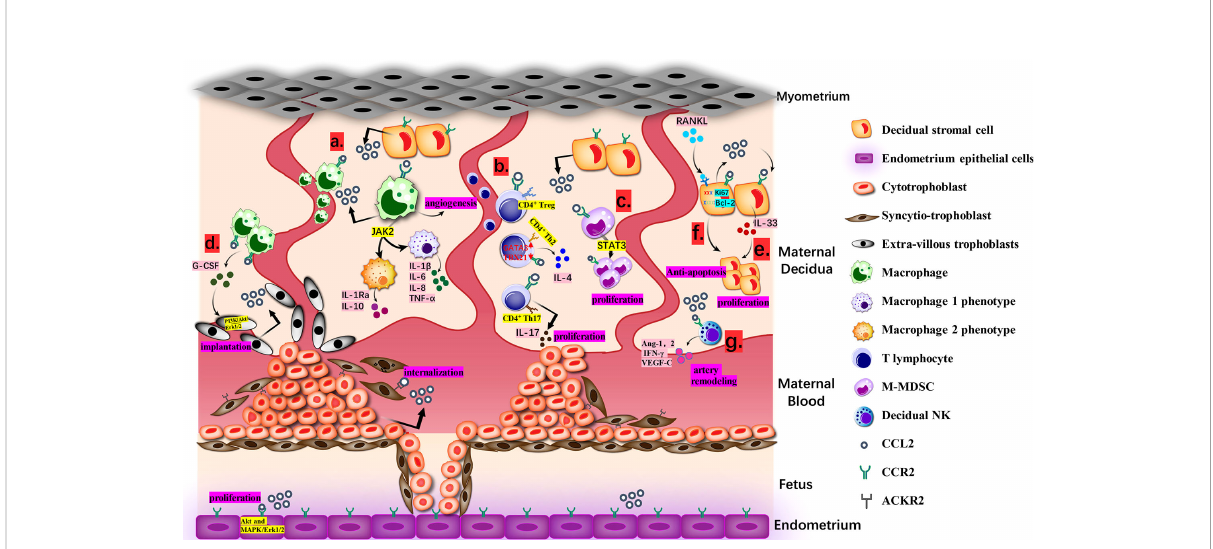
FIGURE 1 Biological Function of CCL2 at the Maternal-fetal interface. (A) . Macrophages from maternal blood produce CCL2 and recruit extra macrophages. Janus kinase 2 (JAK2) is the desirable effector downstream of CCL2-CCR2 for keeping an optional balance of M1 and M2 phenotypes. M1 produces IL-1 b , IL-6, IL-8, TNF- a and M2 produces IL-1Ra and IL-10. (B) . CCL2 recruits CD4 + T cells, including Th 2, Th17 and T regulatory cells (Treg cells). The ration of transcription factors GATA3 and T-bet (TBX21) in naive T cells goes up, deciding the bias of Th2 polarization for the tolerate gestation with accumulative IL-4.Th17 cells approach DSC with the guidance of CCL2-CCR2 axis and then generate IL-17 to endorse trophoblast proliferation and control its apoptosis. (C) . M-MDSCs multiply at maternal-fetal interface via CCL2/STAT3 pathway and can attenuate the activity of T cells. (D) . CCR2 + CD11c high macrophages can be gathered to EVT via combining with CCL2 and then regulate the growth and invasion of EVT through PI3K/Akt/Erk1/2 pathway for stronger implantation. (E) . CCL2 causes the proliferation and invasion of DSCs directed by IL-33. (F) . CCL2 and CCR2 expression caused by RANKL/RANK increased Ki67 and Bcl-2 and reduced FasL, making sure the anti-apoptosis and increment of DSC. (G) . With high level of CCL2, dNK cells generate angiopoietin-1 (Ang-1), Ang-2, IFN- g and VEGF-C to dedifferentiate and degrade VSMC, which is a requisite step in spiral artery